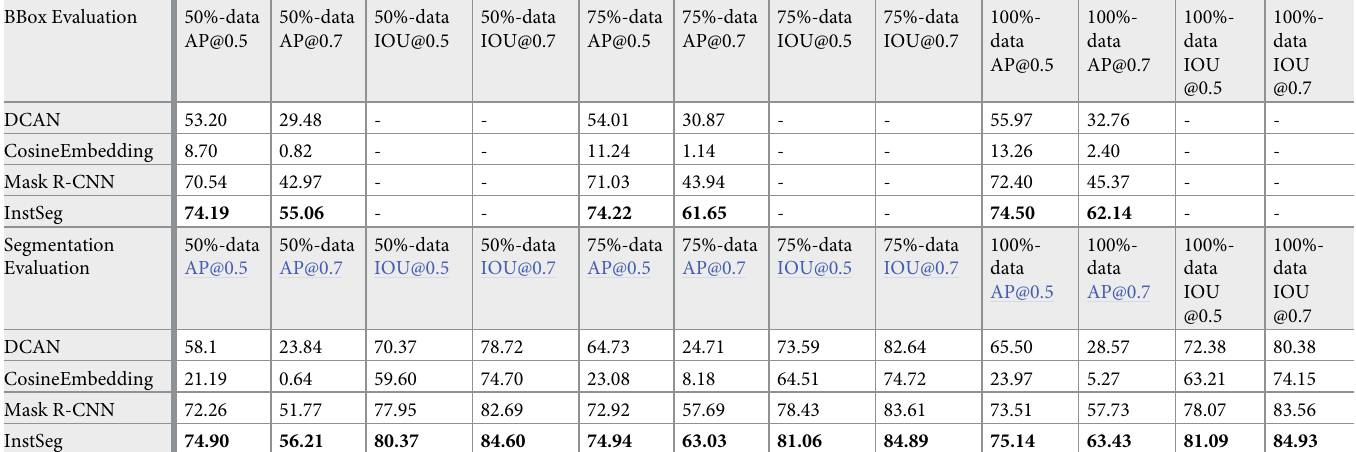
Table 1. The evaluation accuracy (%) for bounding box generation and instance segmentation. The upper part of the table is related to object detection (bounding boxes), and the lower part is related to instance segmentation. We used DCAN, CosineEmbedding, and Mask R-CNN for the other ANN architectures. When the entry is not applicable, dash (-) is used.